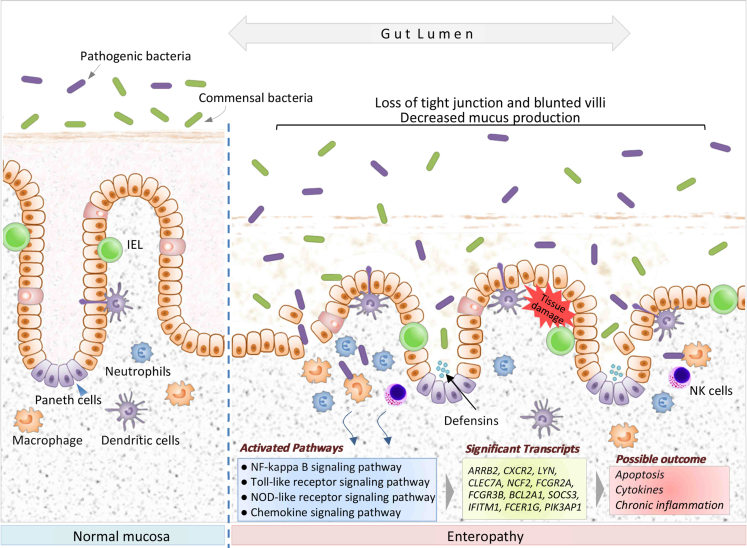
Summary of the current understanding of the pathobiology of environmental enteric dysfunction. EED is characterized by increased interaction between epithelial cells and microbes, resulting in changes in the architecture of the small bowel and disruption of the barrier. This is a result of some disruption of the mucous layer, and potentially a dysbiosis between commensal and pathogenic microbes, which include viruses. Multiple immune pathways are chronically activated by this ongoing exposure. Nutrient absorption is reduced owing to the reduction in surface area of the epithelium and damage to the absorptive villi. IEL, intraepithelial lymphocyte; NF, nuclear factor; NK, natural killer; NOD, nucleotide-binding oligomerization domain.